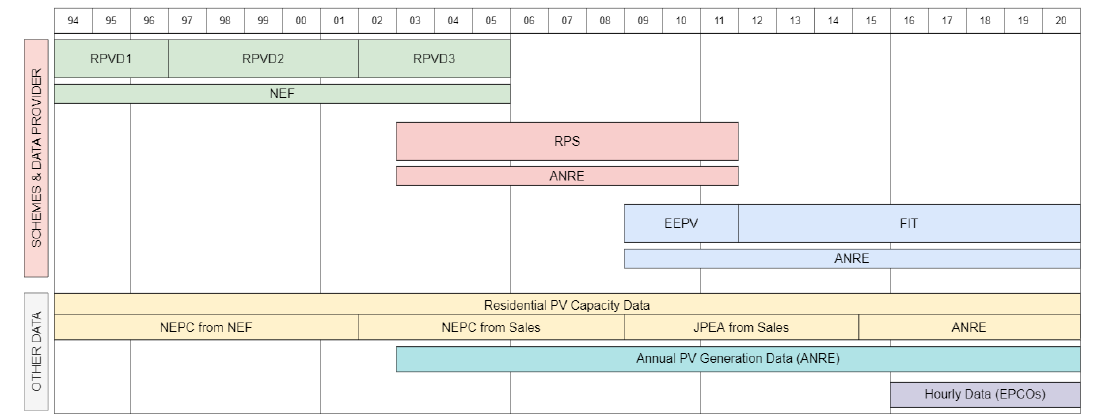
Figure 1. Timeline of schemes and related data collection in Japan between 1994 and 2020. EEPV in this figure stands for “Excess electricity purchasing scheme for